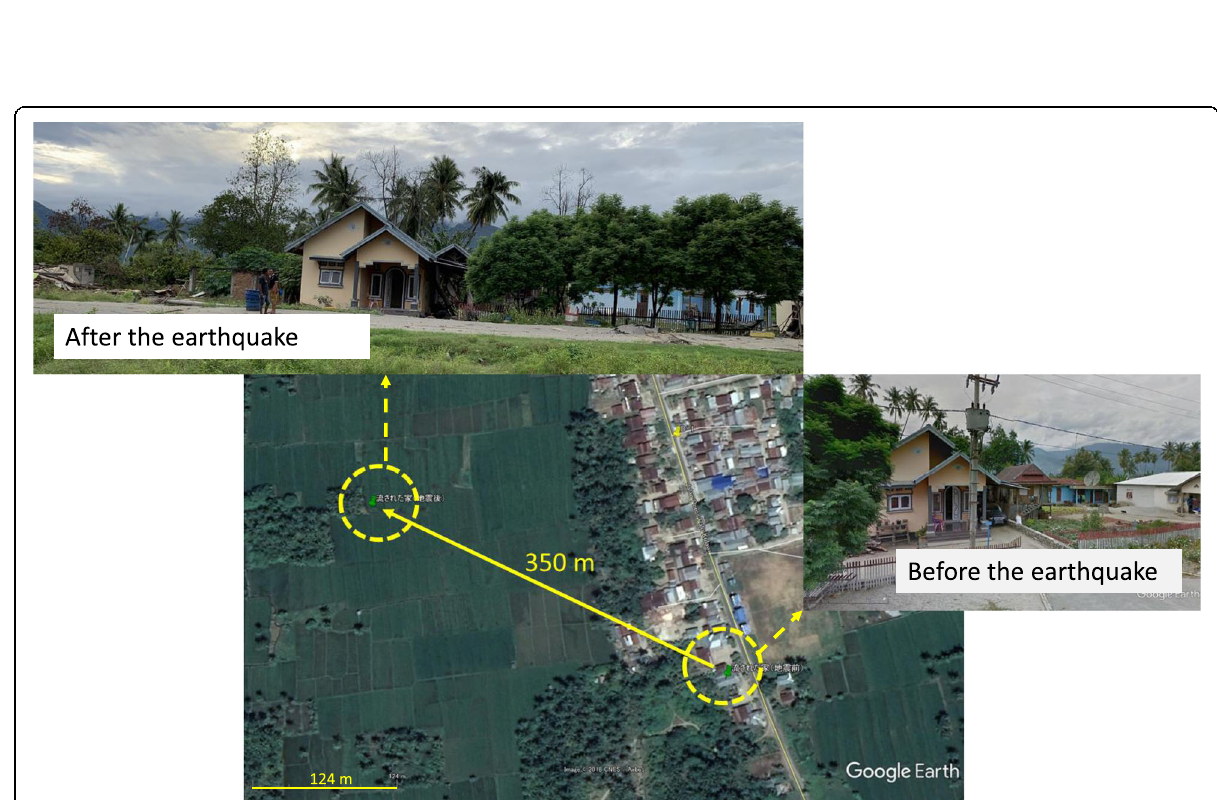
Fig. 14 Location of the moved house in Sibalaya